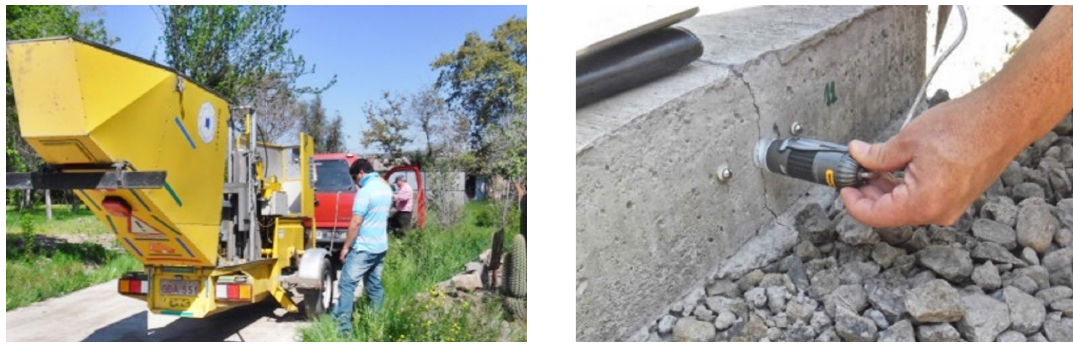
Figure 3. Measurements of LTE and crack width in test section of short concrete slabs